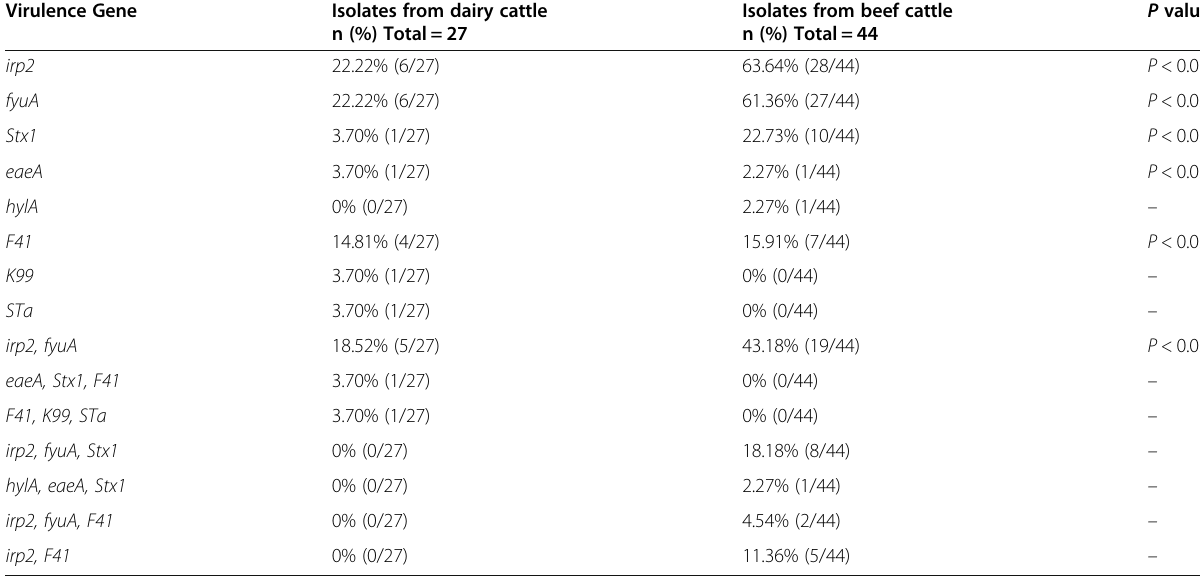
Table 4 Distribution pattern of virulence genes in isolates from dairy cattle and beef cattle Virulence Gene Isolates from dairy cattle n (%) Total = 27